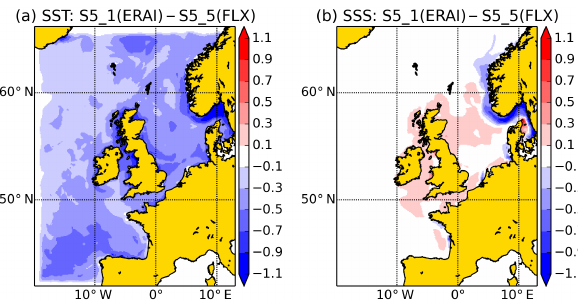
Figure 18. Comparison of mean SST (a) and SSS (b) differences between ERAI fluxes and NWP fluxes (S5_1 vs. S5_5).